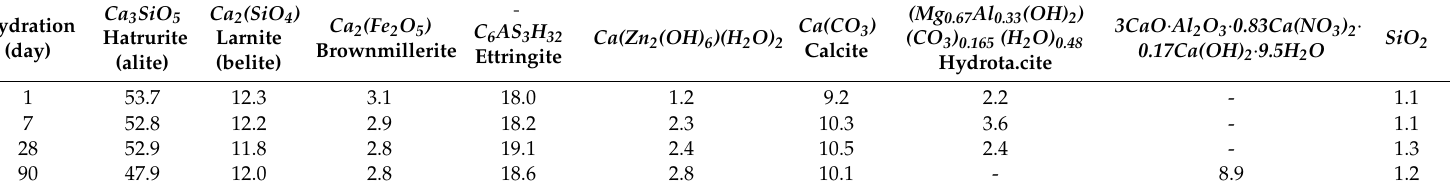
Table 4. Mineral composition of sample with Zn(NO 3 ) 2 · 6H 2 O.